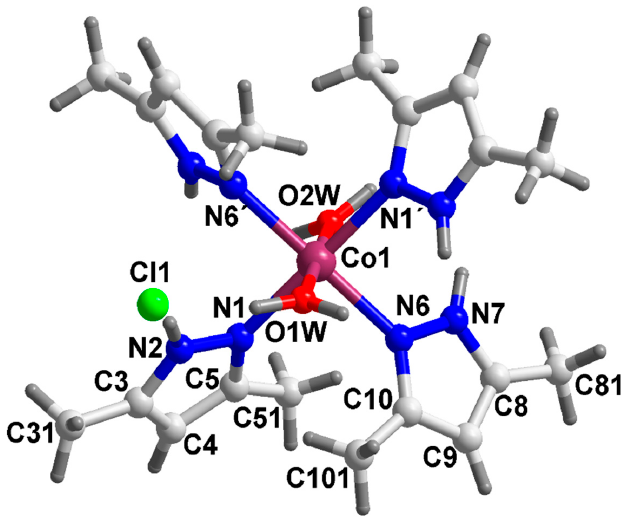
Figure 5. Molecular structure of [Co(Hdmpz) 4 (H 2 O) 2 ]Cl 2 ( 2 ). Symmetry codes for N1 ′ and N6 ′ : 1 − X, +Y, 3/2 − Z.